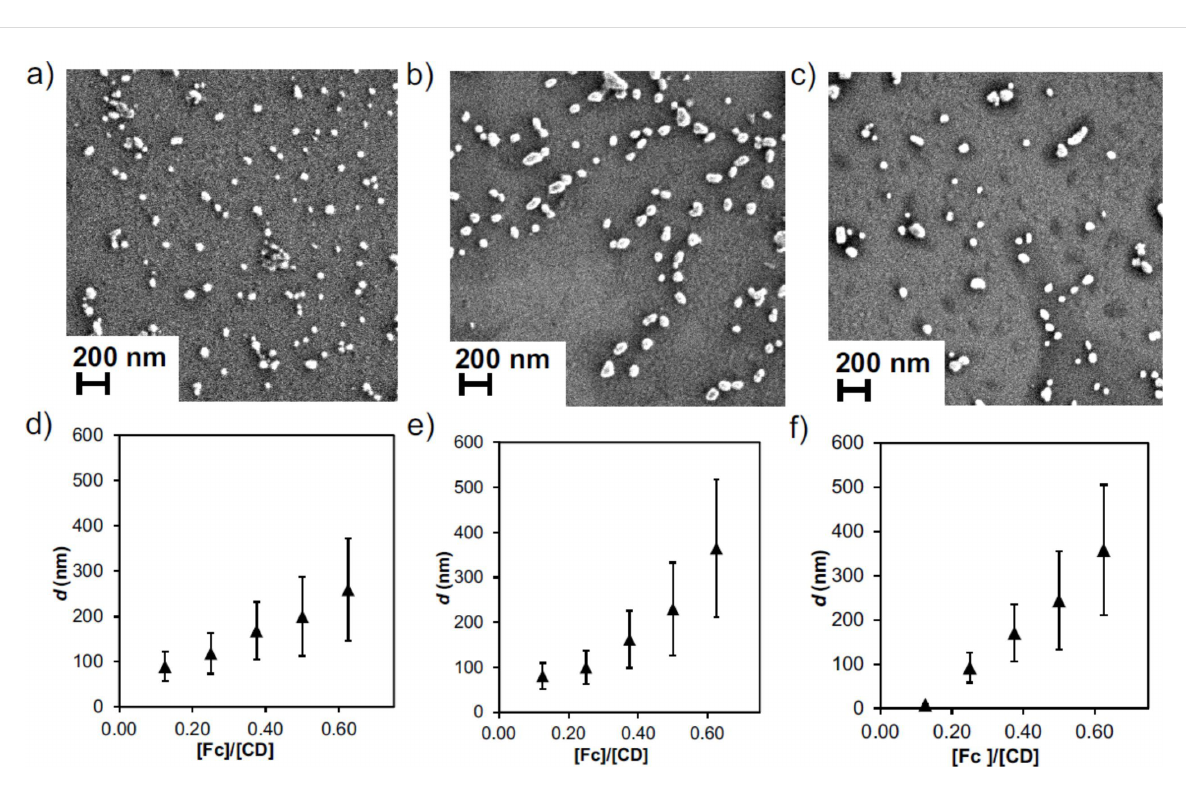
Figure 7: Size determinations of SNPs prepared from CD-PEI, Fc 8 -PAMAM and Ad-PEG: SEM images (a–c) of the resulting SNPs by increasing [Fc]/[CD] ratios (in Fc and CD moieties from Fc 8 -PAMAM and CD-PEI, respectively) using 0.2 M NaCl (a: 0.375, b: 0.50 and c: 0.625) used during supramolecular assembly using [CD] = 100 μ M and CD:(Ad + Fc) stoichiometry, and DLS data (d–f) after: d) 20 min, e) 4 h and f) 7